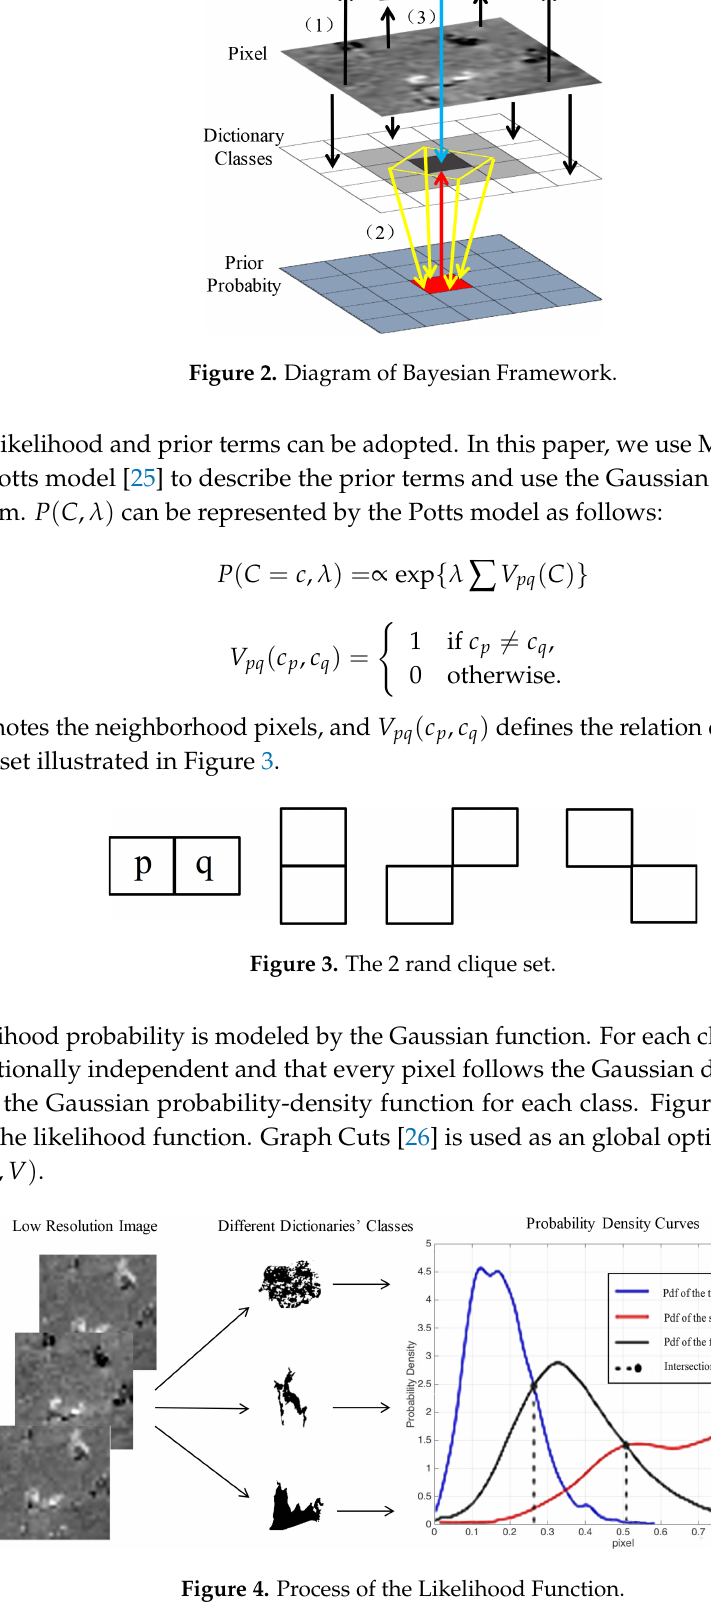
Figure 4. Process of the Likelihood